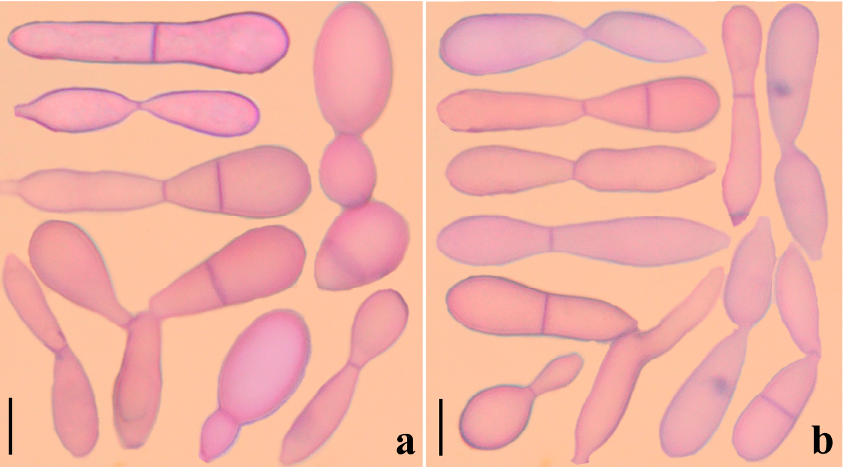
Figure 6. Blastospores of some Arthrobotrys species. ( a ) The blastospores produced by A. oligospora ; ( b ) The blastospores produced by A. conoides . Scale bars = 10 µm. ( b ) The blastospores produced by A. conoides . Scale bars = 10 µ